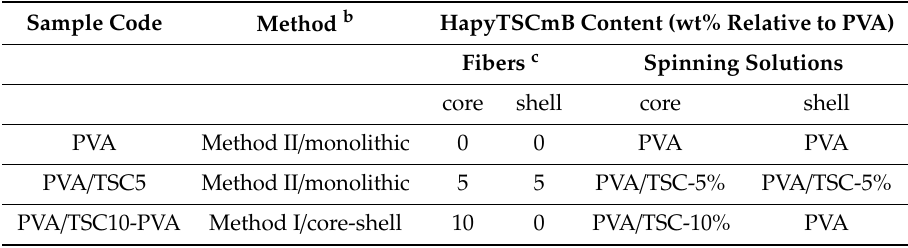
Table 1. Essential parameters for the fabrication of PVA and PVA / TSC fibers a